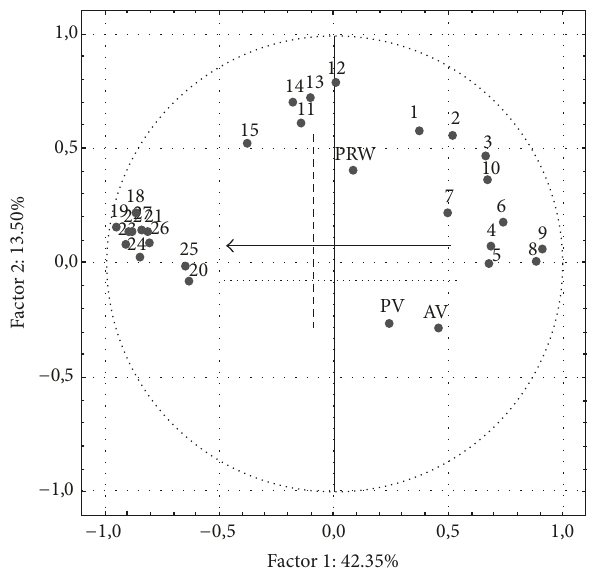
Figure 7: Correspondence analysis for pycnidiospores and ascospores of Zymoseptoria tritici in 1998-1999. Association between PRW, PV, AV, and weather variables as rainfall, relative humidity, radiation, and temperature (3, 7, 15, 30, and 60 days